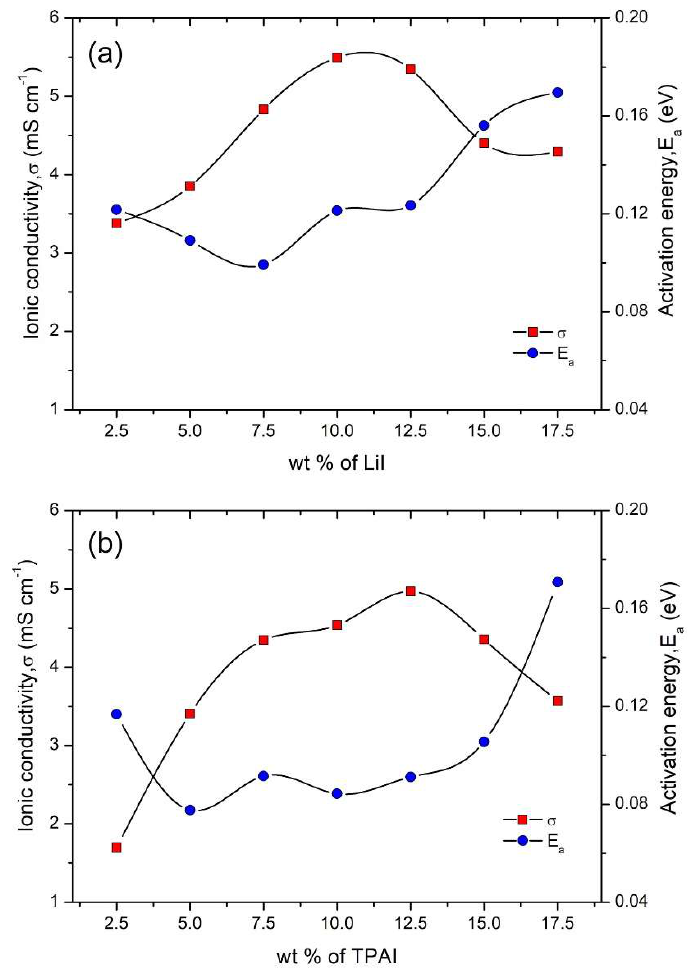
Figure 7. Ionic conductivity (at 30 ◦ C) and activation energy of PhSt-HEC-DMF with ( a ) LiI and ( b ) TPAI